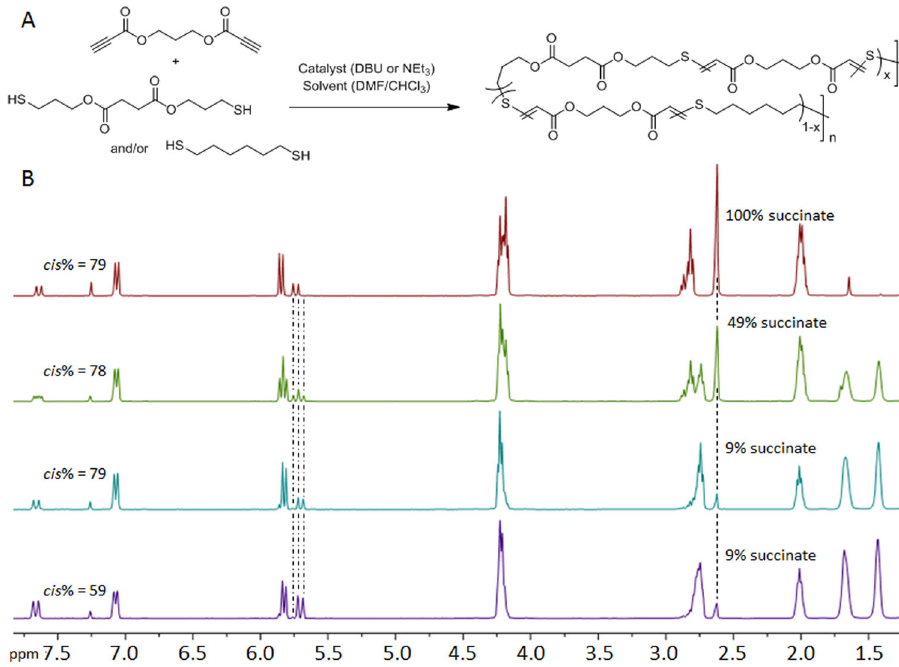
Fig. 1 Stereocontrolled synthesis and characterization of the resorbable elastomers. A A one-pot thiol-yne step-growth polymerization of propane-1,3- diyl dipropiolate (C 3A , 1 ) with bis(3-mercaptopropyl) succinate ( 2 ) and with 1,6-hexane dithiol (C 6S ) forms a copolymer that shows tunable degradation rates depending on the % of amount of repeat unit x ( 1 + 2 ) that is incorporated. B The stereochemistry is easily determined by the vinyl proton doublets at δ = 5.7 and 7.7 ppm ( trans , 15 Hz) and δ = 5.8 and 7.1 ppm ( cis , 9 Hz), respectively. The extent of succinate incorporation will determine both the rate and extent of degradation.